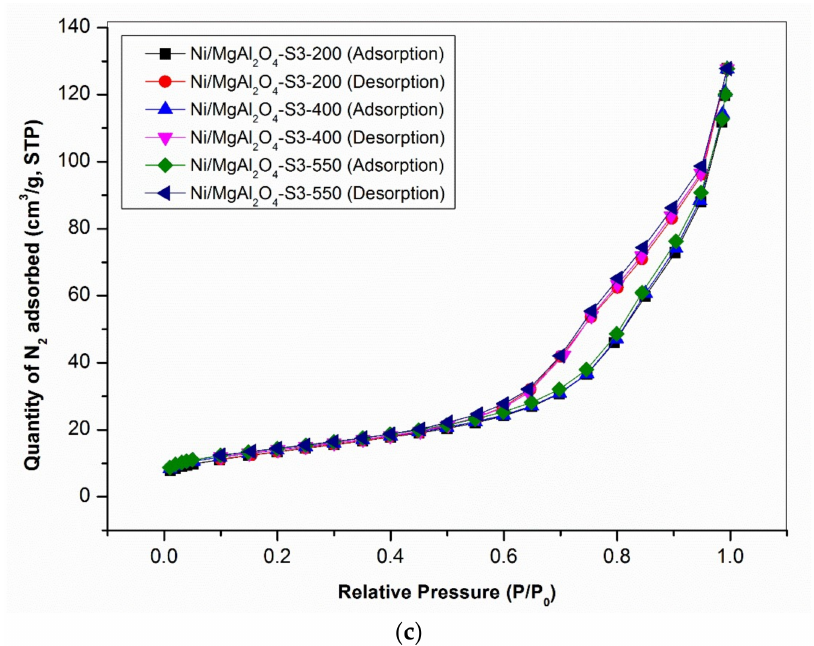
Figure 13. ( a ) N 2 adsorption–desorption isotherms of Ni/MgAl 2 O 4 sulfided with (NH 4 ) 2 SO 4 (S1) at various temperatures. ( b ) N 2 adsorption–desorption isotherms of Ni/MgAl 2 O 4 sulfided with (NH 4 ) 2 S (S2) at various temperatures. ( c ) N 2 adsorption–desorption isotherms of Ni/MgAl 2 O 4 sulfided with DMSO (S3) at various temperatures. Table 2. Surface area, pore volume, pore size, and crystallite size of supported catalysts.